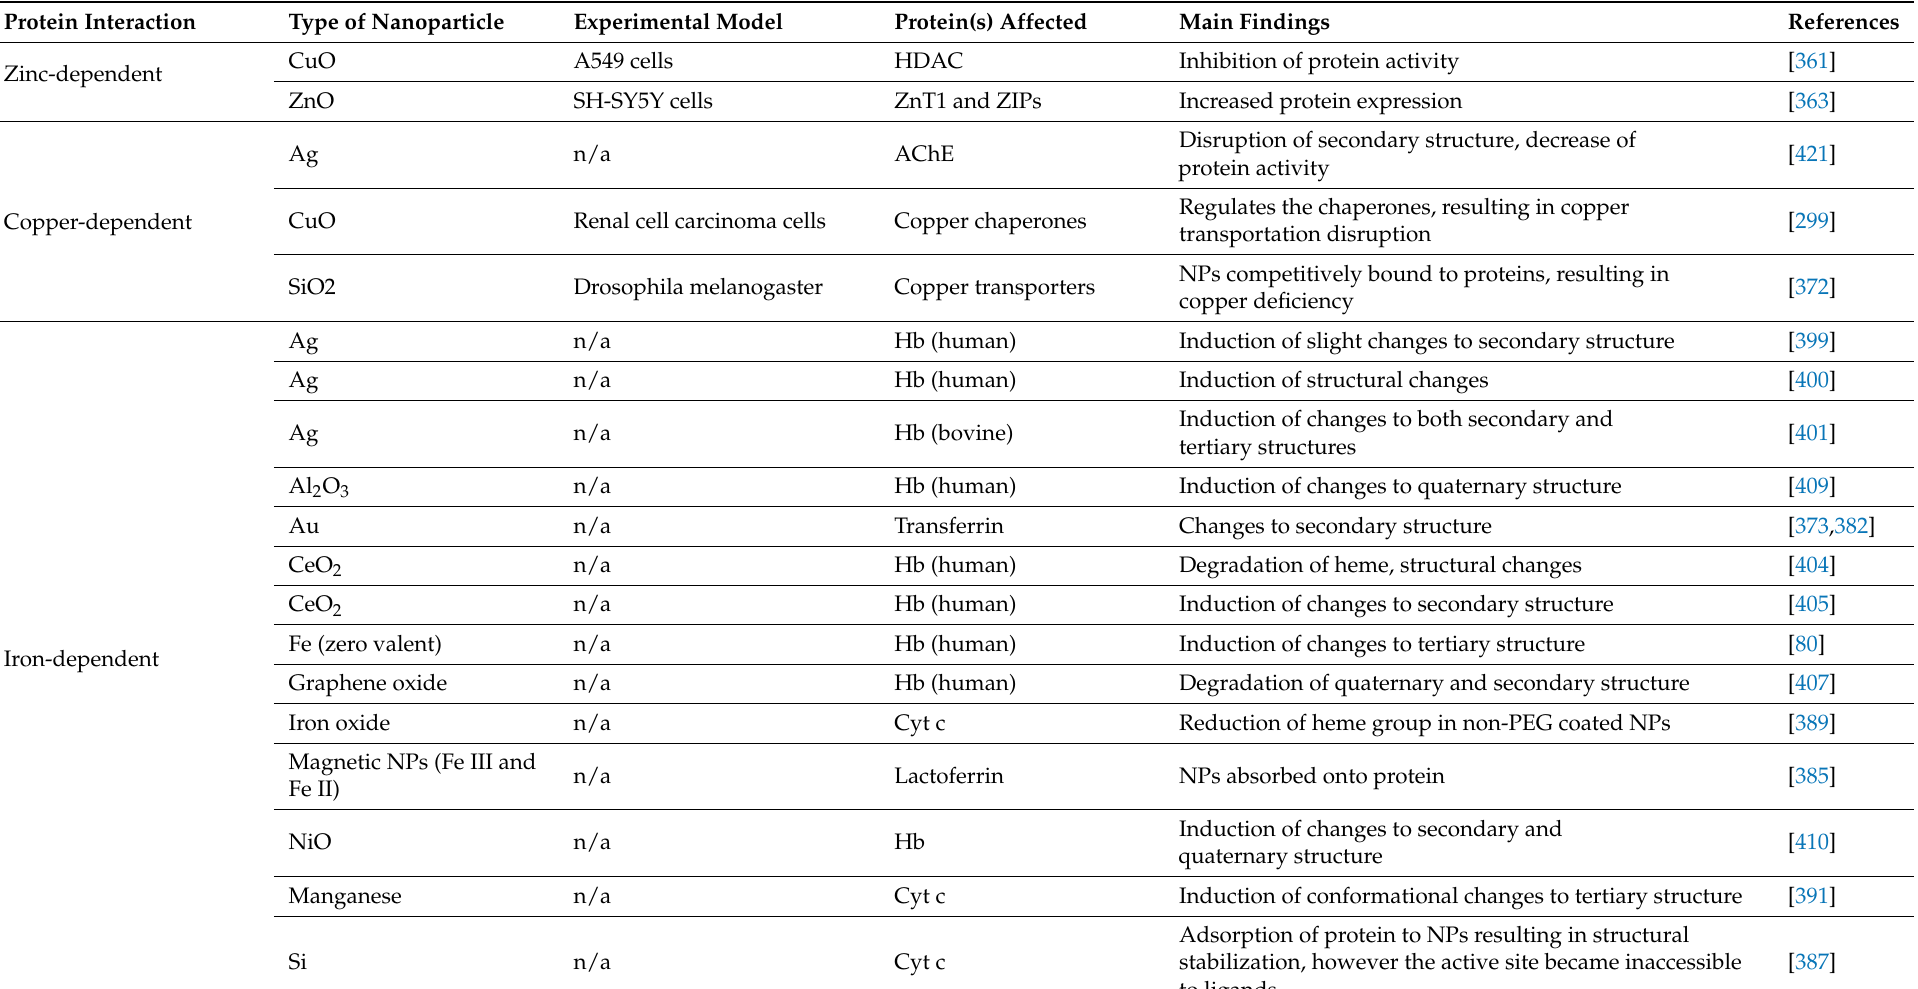
Table 7. Summary of effects of various nanoparticles on zinc-dependent, copper-dependent, iron-dependent, and calcium-dependent proteins in different experimental